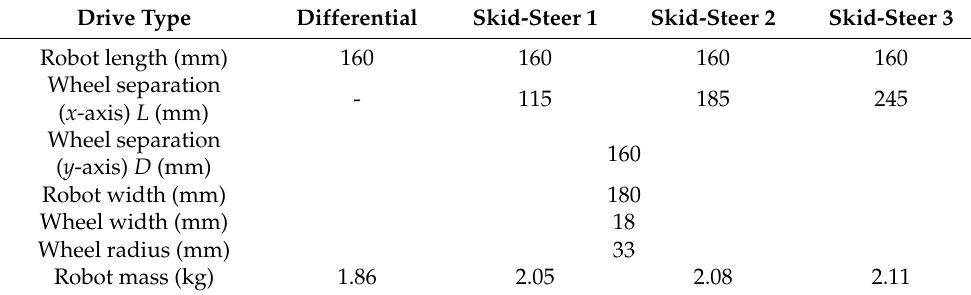
Table 1. The dimension of tested robots.